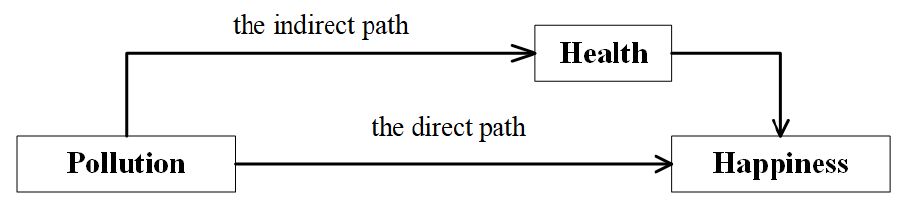
Figure 1. Mediating effect model of health.